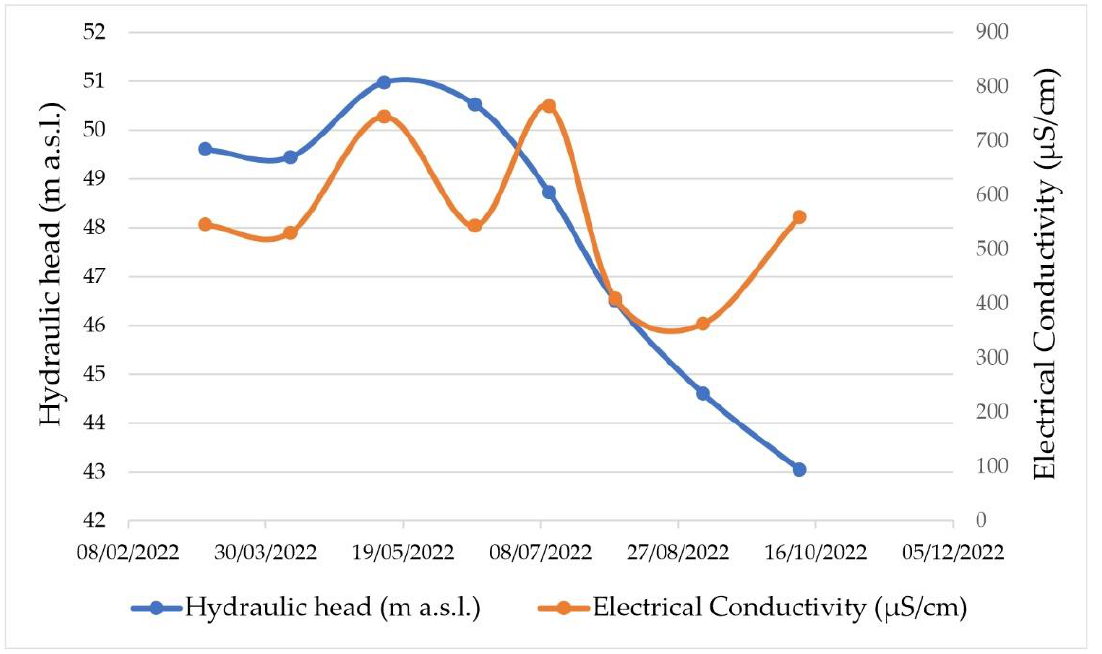
Figure 8. Hydraulic head fluctuations vs. groundwater EC in Pz3 (dates are given in day/month/year).